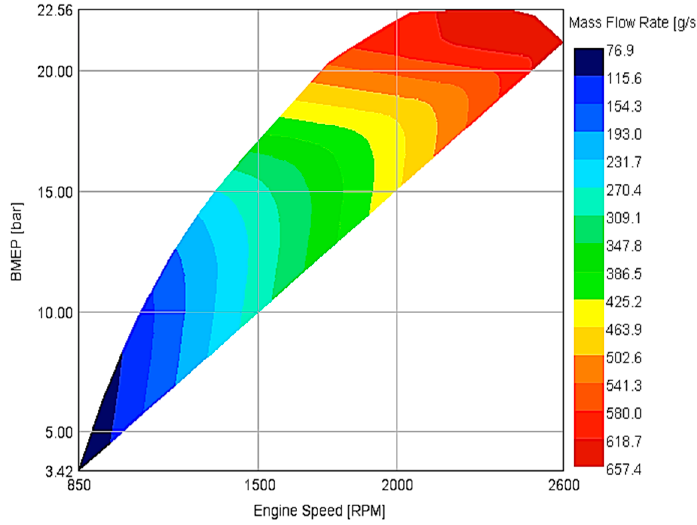
Figure 9. Variation of exhaust gas mass flow rate in accordance with engine speed and BMEP.